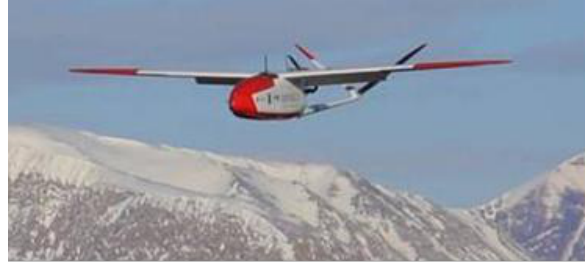
Figure 2. The CryoWing UAS.